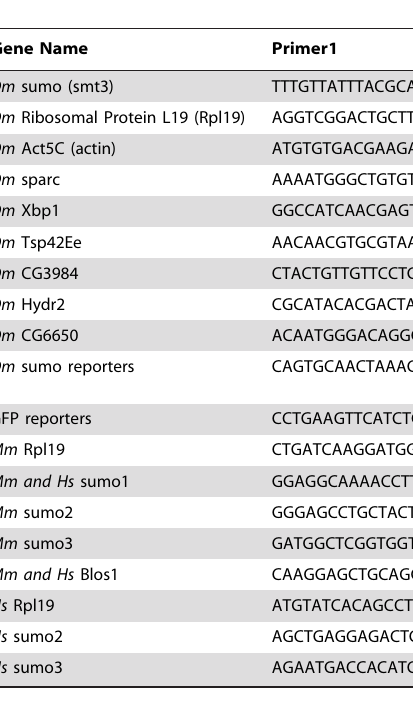
Table 1. Primers used for